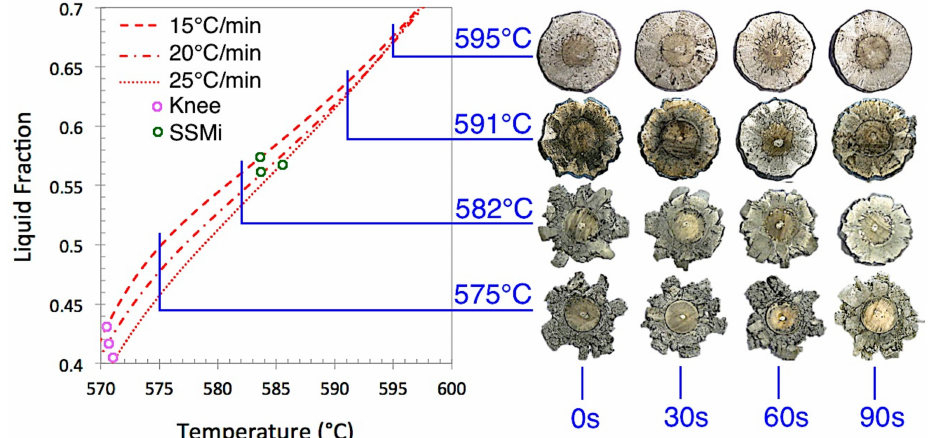
Figure 7. f l vs. T curves (in red) derived from DSC data for B319+Fe alloy at heating rates of 15, 20, and 25 ◦ C/min. The four temperatures chosen for the thixoforming tests (575, 582, 591, and 595 ◦ C) are indicated by horizontal blue lines. Thixoformed disks after isothermal heat treatment at these temperatures for 0, 30, 60, and 90 s are shown to the right of the graph. The eutectic knee (purple circles) and lower limit of the SSM working window (green circles) are also highlighted on the